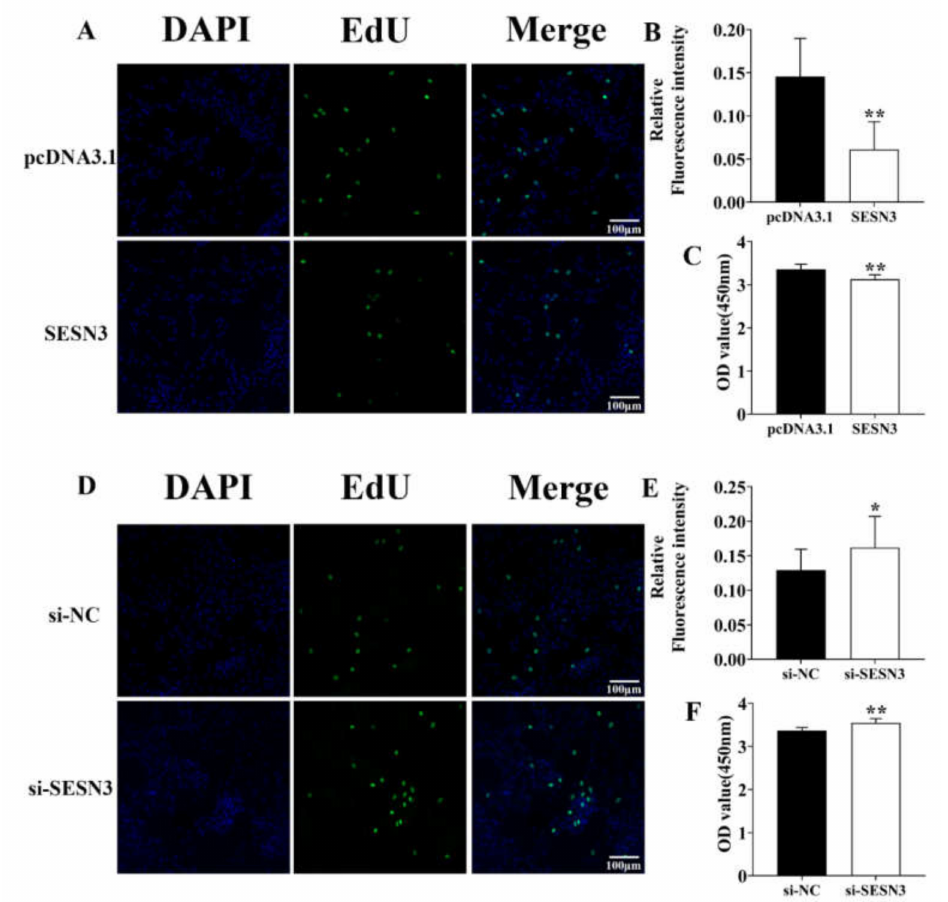
Figure 1. SESN3 inhibited pre-adipocyte proliferation. ( A , D ) Detection of pre-adipocyte positive EdU level after transfecting pcDNA3.1-Sesn3-CDS vector ( A ) or si-Sesn3 ( D ) for 48 h. The proliferating nuclei were stained green with EdU (50 µ M) for 4 h, while the nuclei of all cells were stained blue with Hoechst33342 for 30 min. The scale bar was 100 µ m. ( B , E ) Quantification of the relative fluorescence intensity of EdU-positive cells (EdU/DAPI) using ImageJ software. ( C , F ) The Cell Counting Kit- 8 assay (CCK-8) detection after transfecting pcDNA3.1-Sesn3-CDS vector ( A ) or si-Sesn3 ( D ) for 48 h (n = 9 per group). The wavelength of CCK-8 detection was 450 nm. Data are presented as mean ± s.e.m. * means P < 0.05, ** means P <